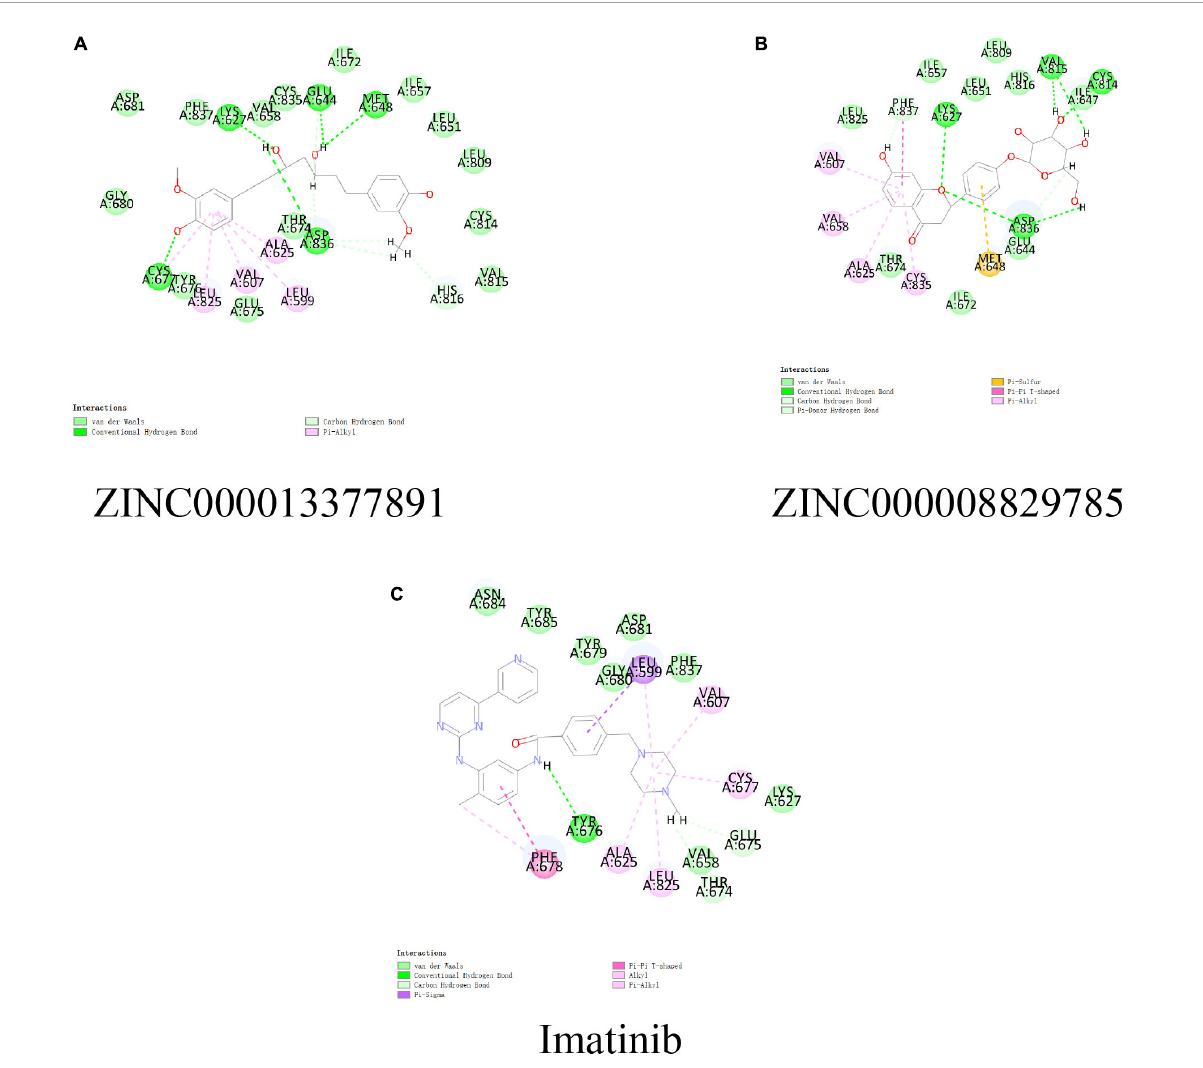
FIGURE4 Schematic of intermolecular interaction in the binding pockets by DS of the predicted binding modes of (B) ZINC000008829785 with platelet-derived growth factor receptor α (PDGFRA), (A) ZINC000013377891 with PDGFRA, and (C) Imatinib with